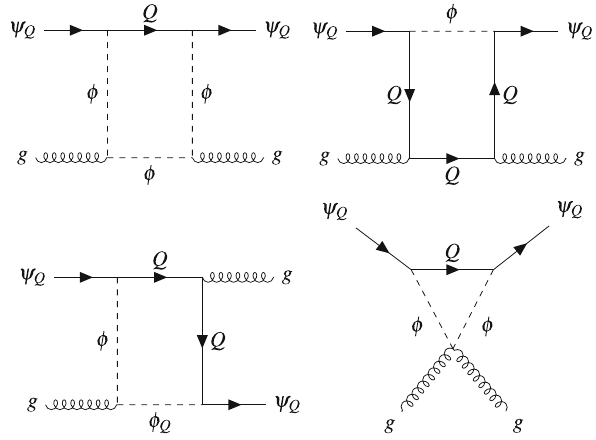
Fig. 3 Leading order diagrams for DM-gluon scattering for quarkphilic DM